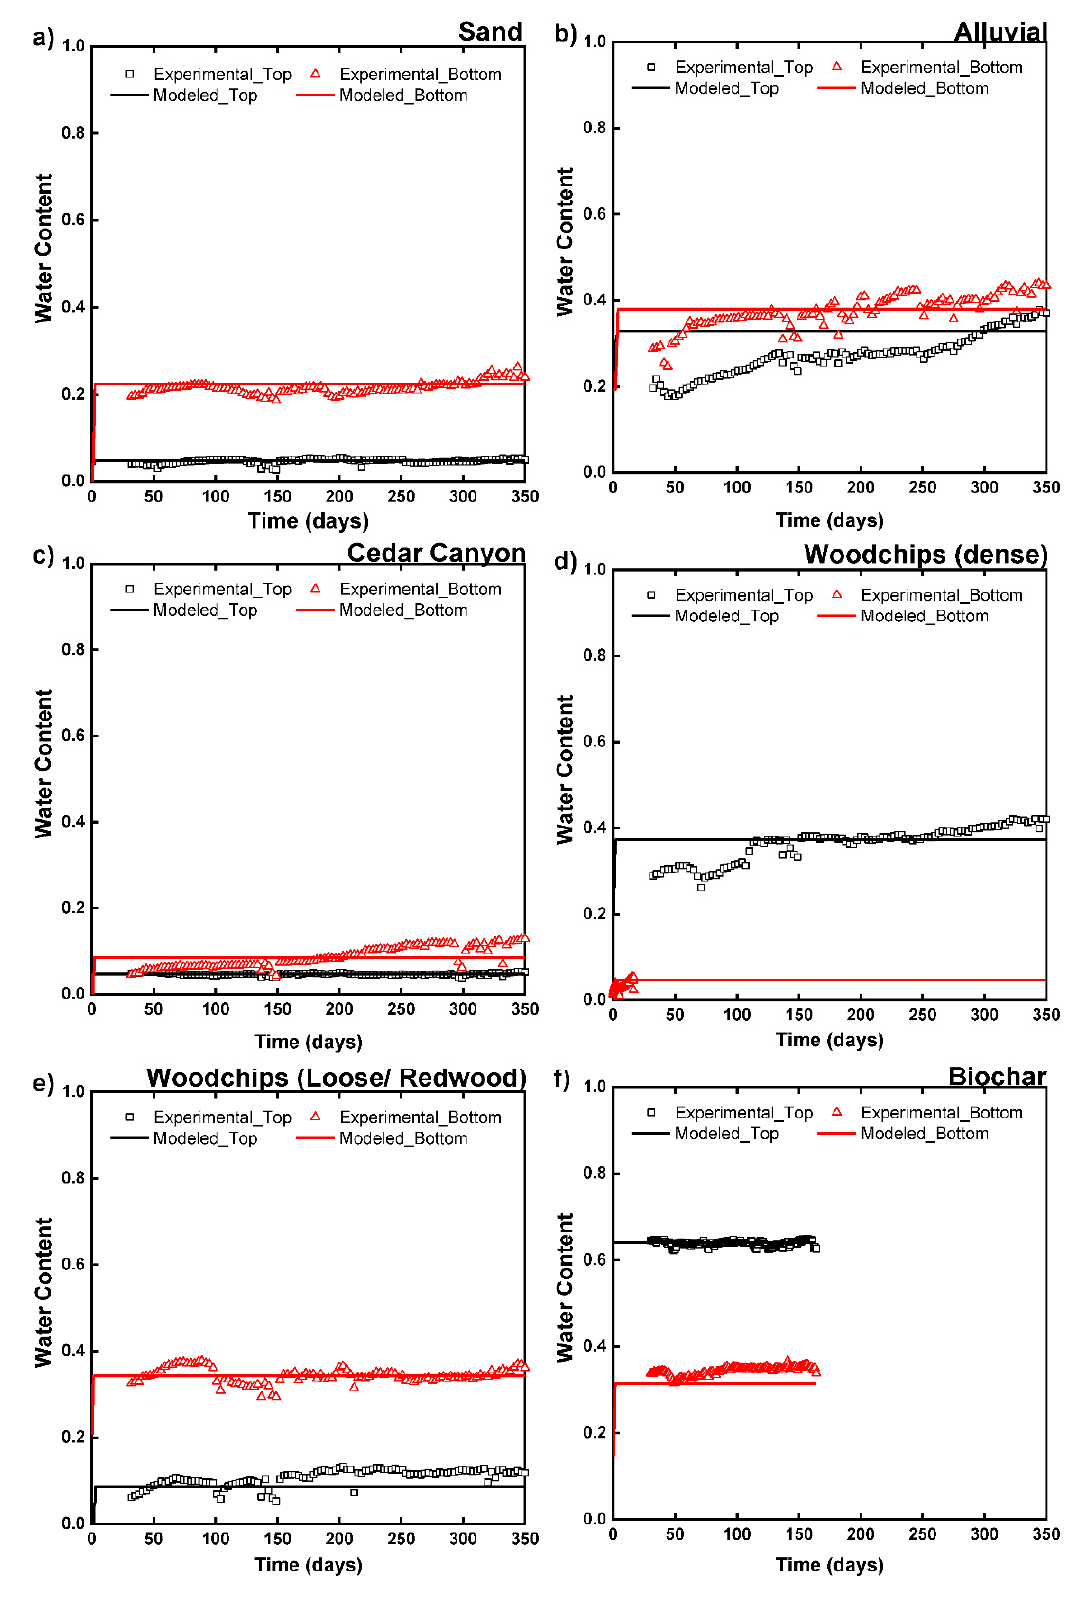
Figure 2. Calibrated Water Content for ( a ) Sand, ( b ) Alluvial, ( c ) Cedar Canyon, ( d ) Woodchips (dense), ( e ) Woodchips (Loose), and ( f ) Biochar. The HYDRUS 2D graphical display for changes in water content with depth for each of the calibrated columns is shown in Figure 3.